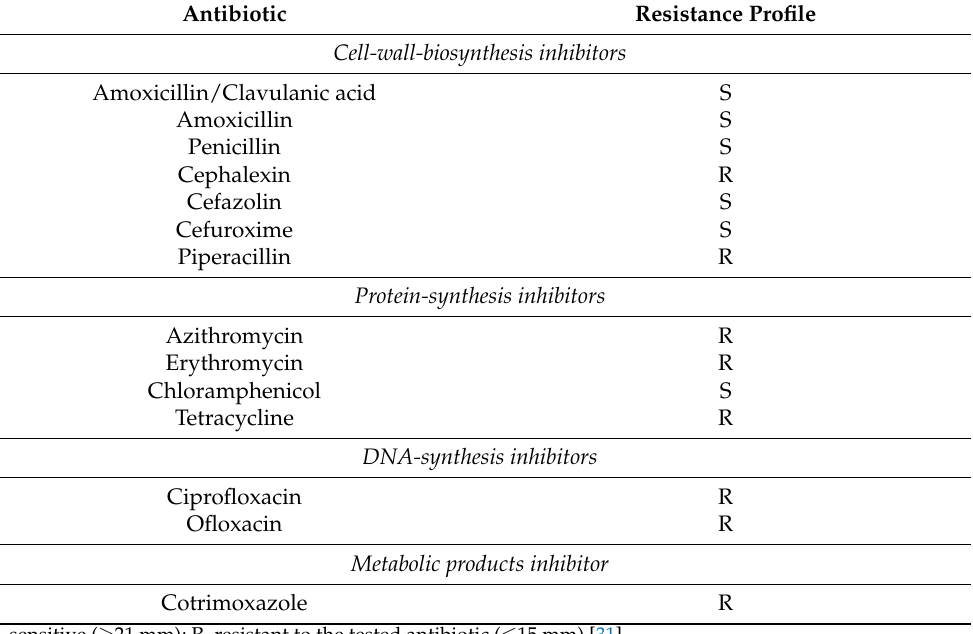
Table 3. Antibiotic-resistance profile.